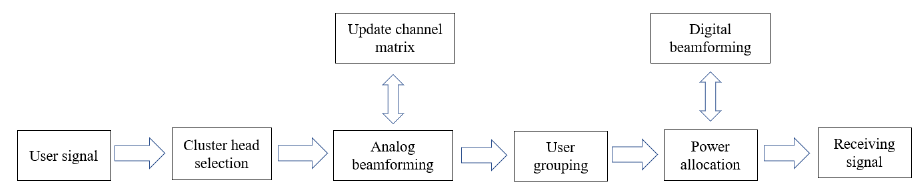
Figure 2. The framework of System